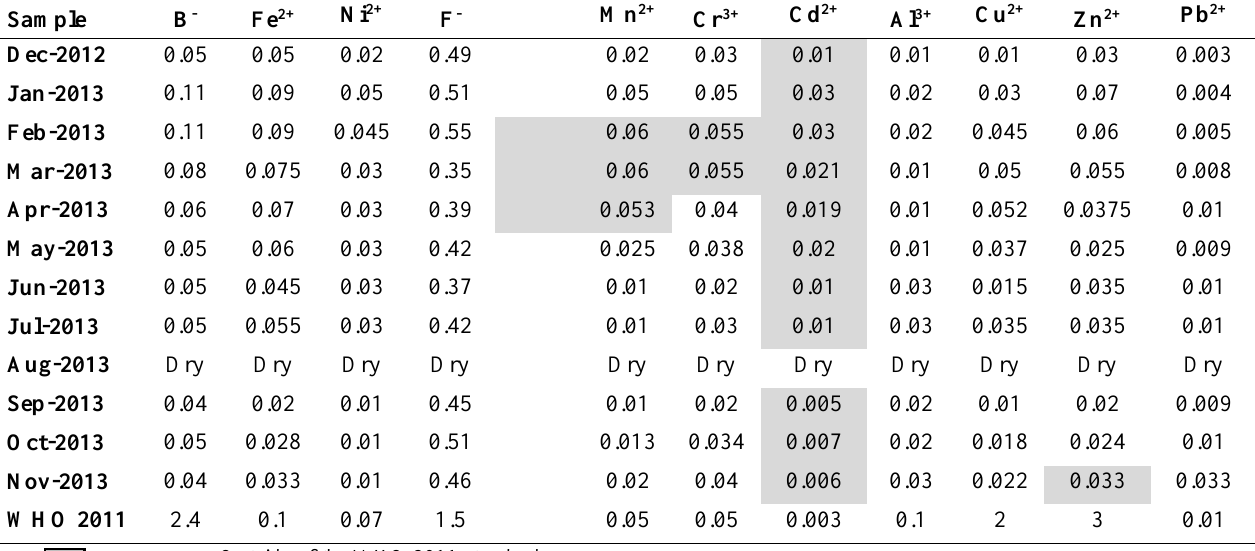
Fig. 1 The geological map of Rahim Abad hydrometric station (After Geological Survey and Mineral Exploration, 2000) Table 1 Heavy metal concentration of the Silakhor River samples